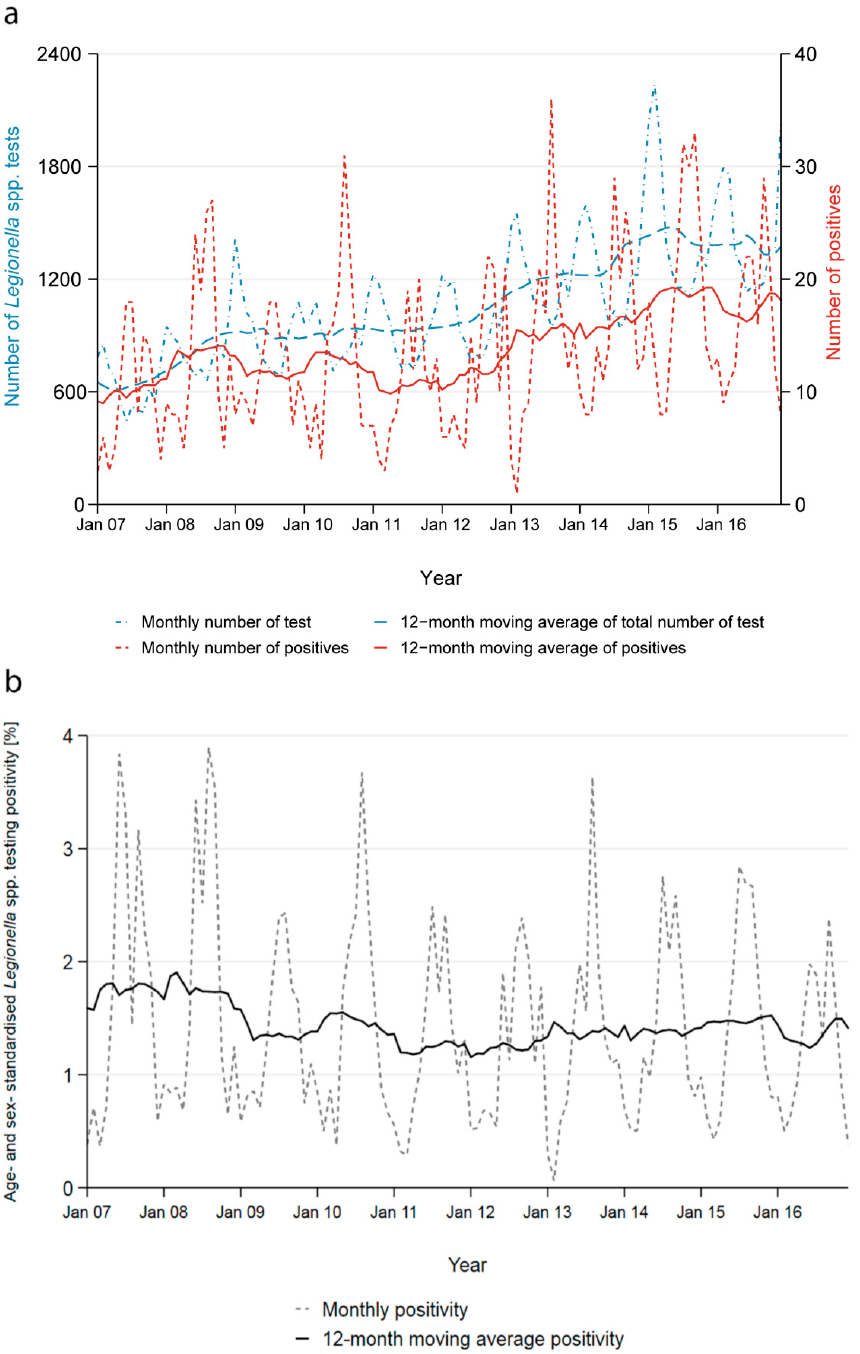
Figure 2. Time trend in test volume, cases and positivity. ( a ) Twelve-months moving average (solid lines) and monthly (dashed lines) number of Legionella spp. tests performed and number of positive tests, for the entire study period (2007–2016) by 14 diagnostic laboratories in Switzerland. ( b ) Twelve-months moving average (solid line) and monthly (dashed line) age- and sex-standardised positivity of Legionella spp. testing, Switzerland,